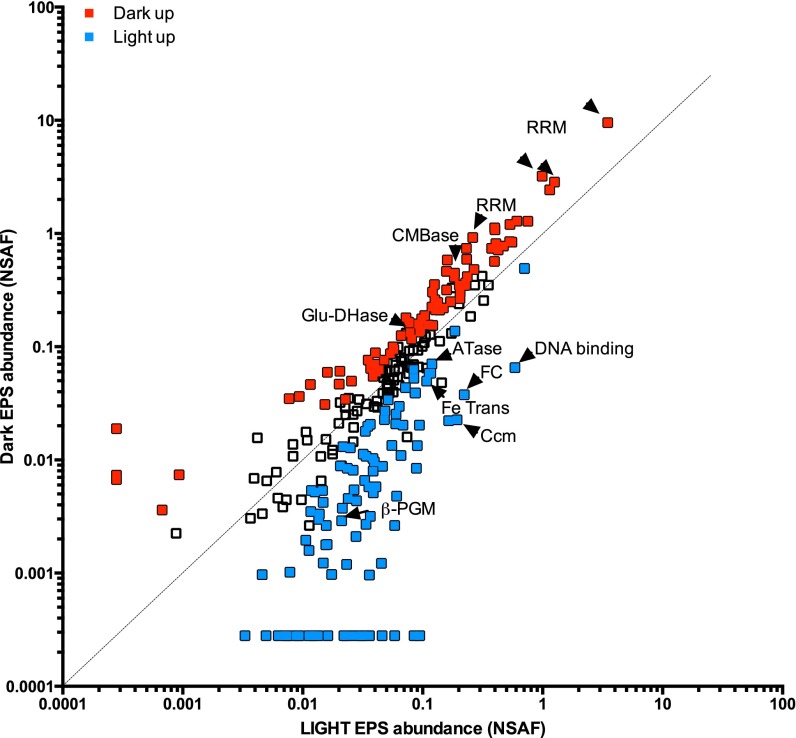
Comparison of the relative abundances determined by shotgun proteomics for the ESFC-1 exoproteome in dark versus light treatments after 3 days. Points represent exoprotein average relative abundances in comparisons between results from 3 and 5 biological replicates and 1 technical replicate (4 to 10 replicates). Relative abundance data were determined from the counts of normalized spectral abundance factors (NSAF). Exoproteins are proteins significantly enriched in the extracellular fractions relative to the total fraction (t test, P < 0.05, log2 fold change > 0.8). Colored points represent proteins with significant differences in abundance between the two treatments (t test, P < 0.05). CMBase, carboxymethylenebutenolidase; Glu-DHase, glucose/sorbosone dehydrogenase; RRM, 4 different RRM domain proteins; ATase, aminotransferase; β-PGM, β-phosoglucomutase; Fe Trans, Fe-regulated ABC transporter ATPase unit; DNA binding, bacterial nucleoid DNA-binding protein; FC, fasciclin domain-containing protein; Ccm, carbon dioxide-concentrating-mechanism protein.